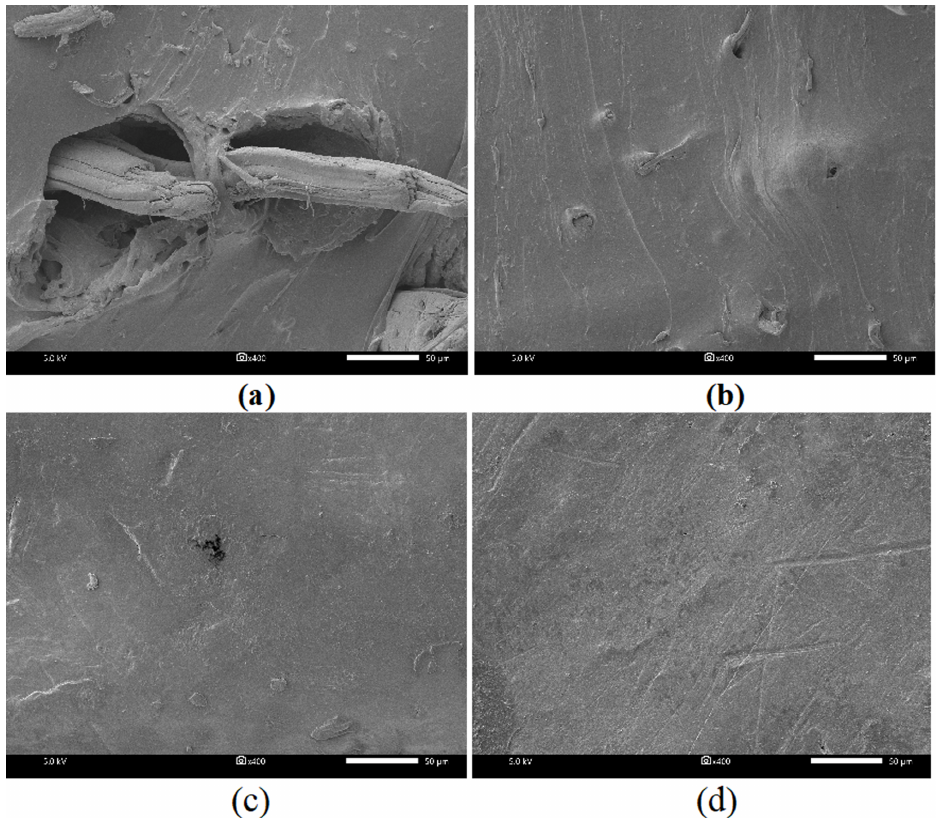
Figure 7. FESEM micrographs of ( a ) NR/JF un , ( b ) NR/A-JF, ( c ) NR/A-St-JF and ( d ) NR/A-Si-JF.